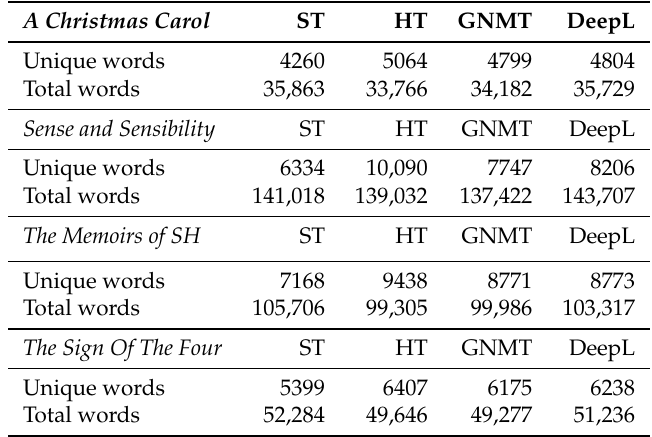
Table 5. Number of unique and total words per novel for ST, HT, GNMT, and DeepL.